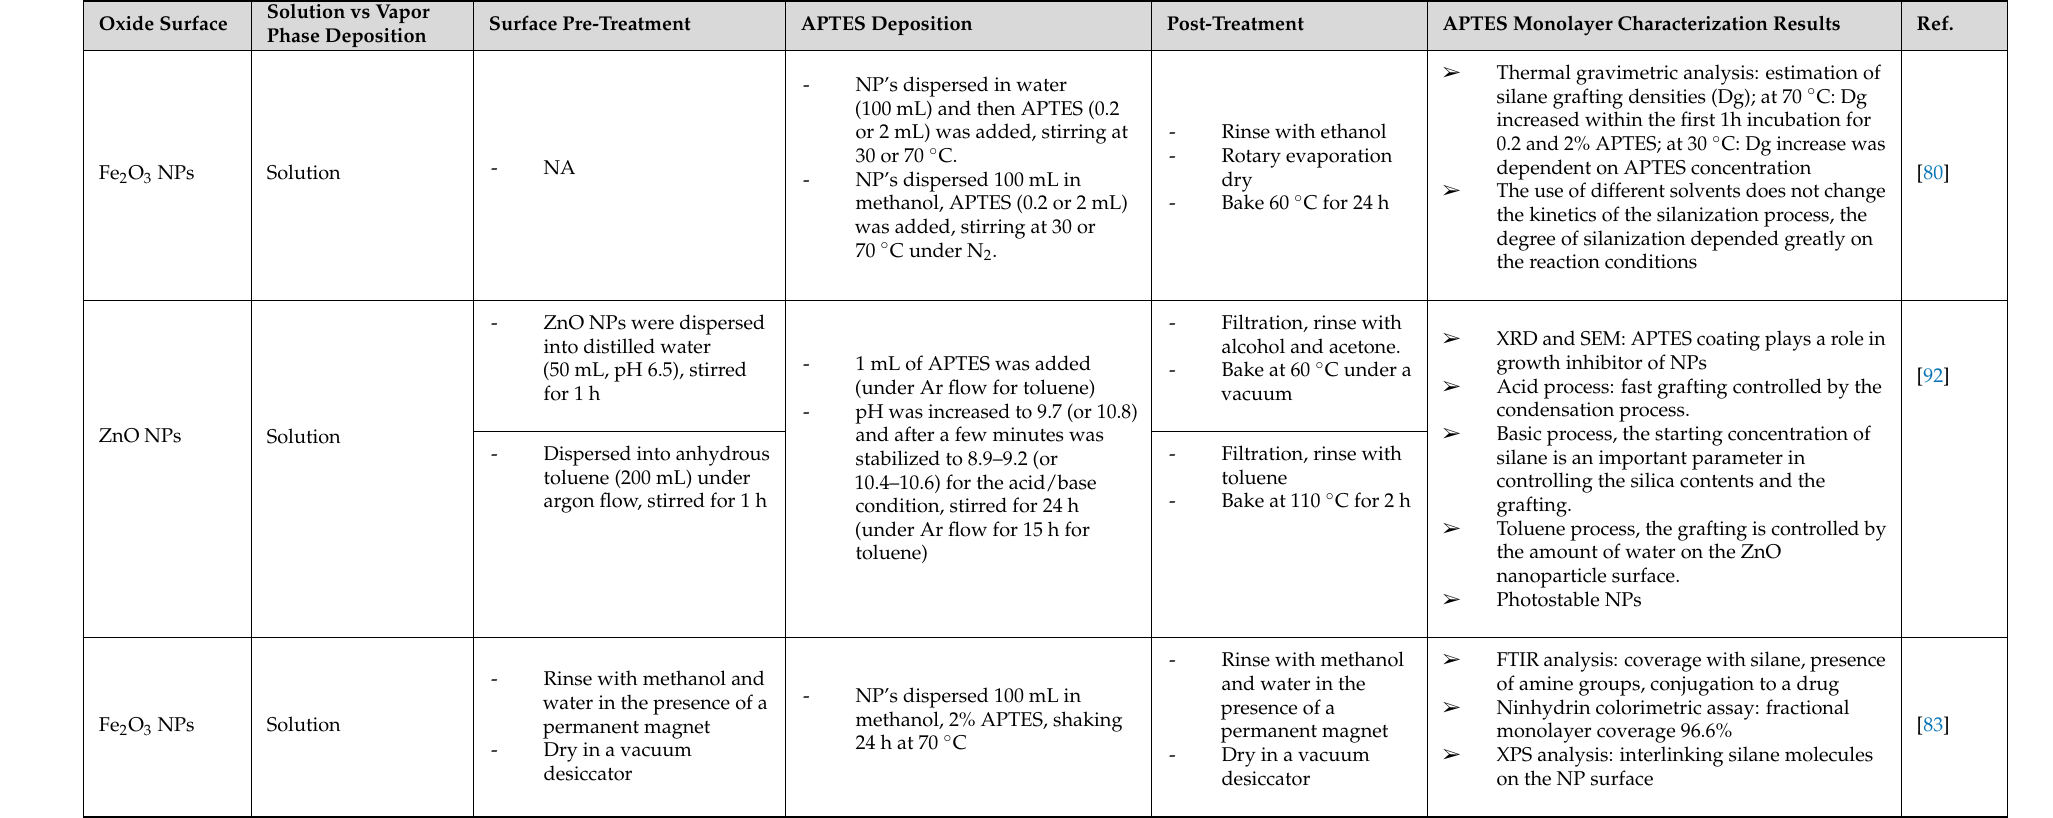
Table 3. APTES grafting methods and characterization results on NP’s